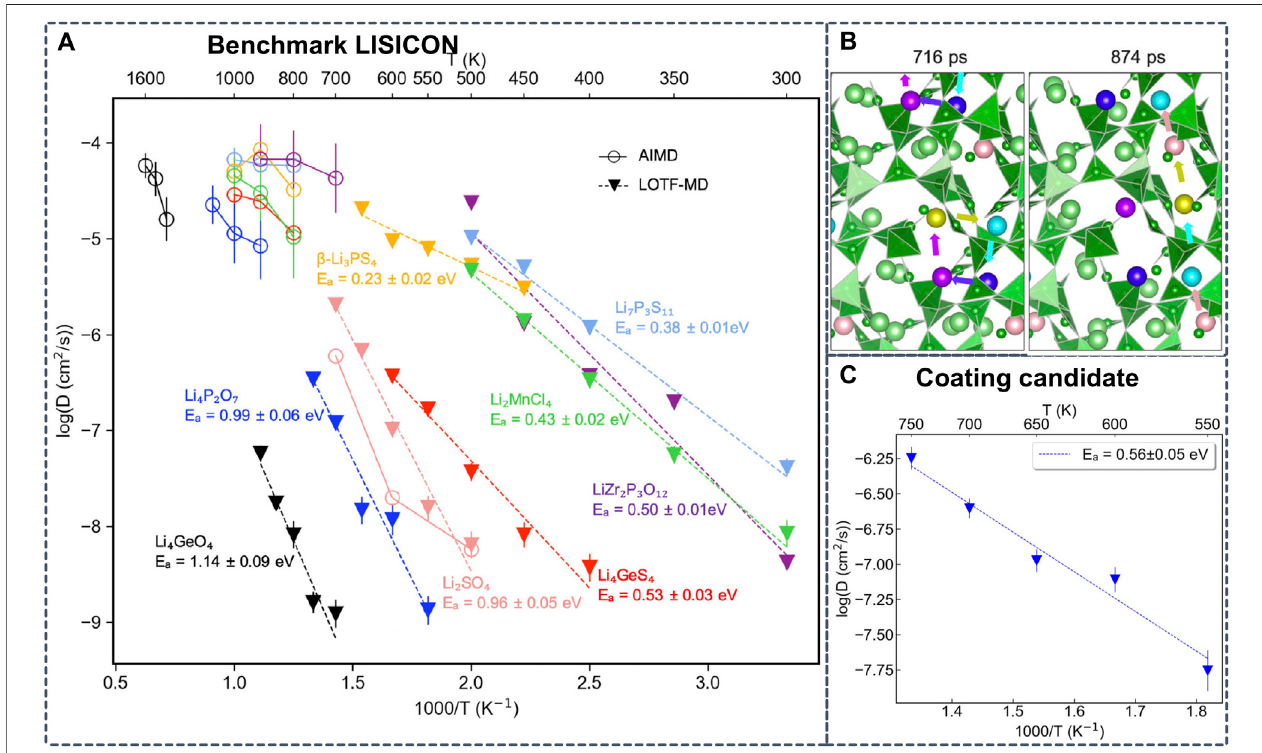
FIGURE 9 | (A) Arrhenius plot with diffusivities obtained from AIMD simulations at high temperatures and from learning on-the- fl y (LOTF)-MD simulations at intermediate temperatures (B) Snapshots from MD simulations that exemplify diffusion via collective motion of Li + in Li 3 B 7 O 12 identi fi ed by LOTF-MD at 700 K (C) Calculated Arrhenius plot of Li 3 B 7 O 12 from LOFT-MD diffusivities. Reproduced with permission from (Wang et al., 2020b). Copyright 2020 American Chemical Society.